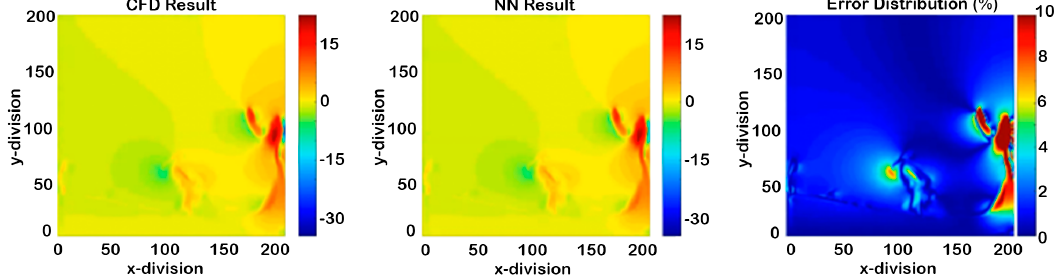
Figure 18. Non-cascading result of Y -direction velocity at the maximum error in the whole process (2.604 s).